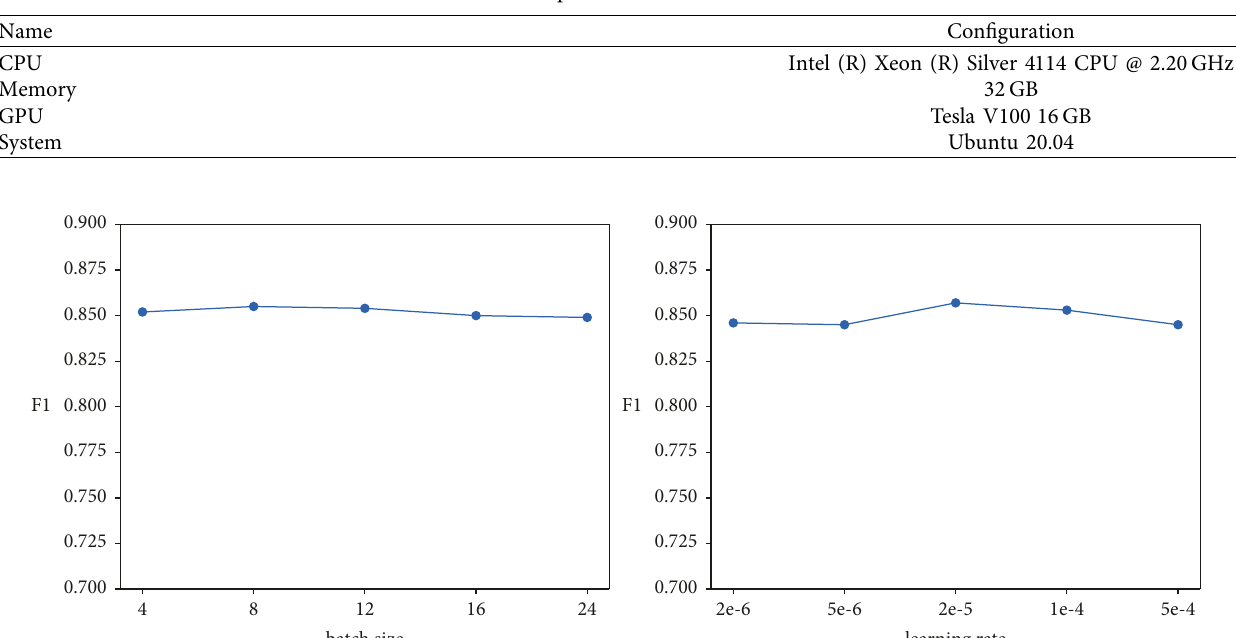
Table 2: Experimental